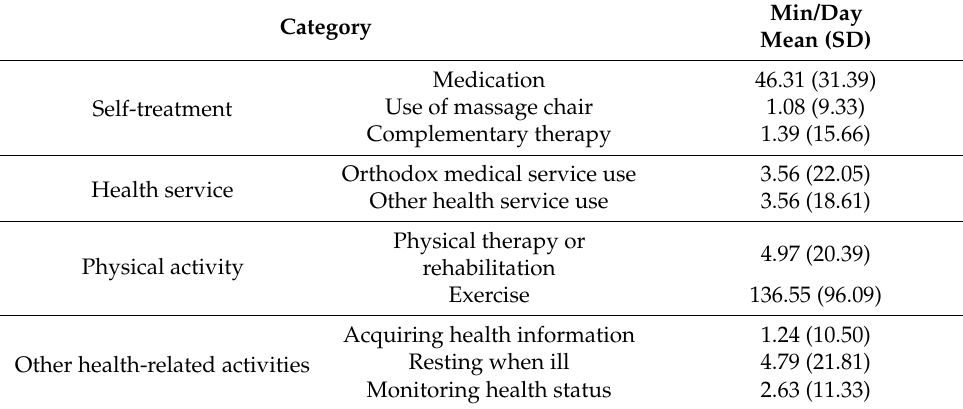
Table 3. Type of health management activities.